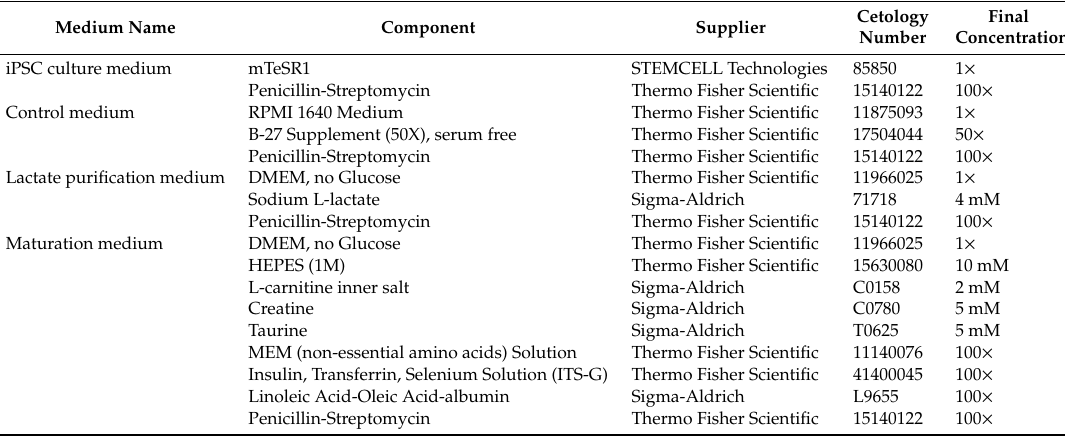
Table 1. The components of di ff erent cell culture